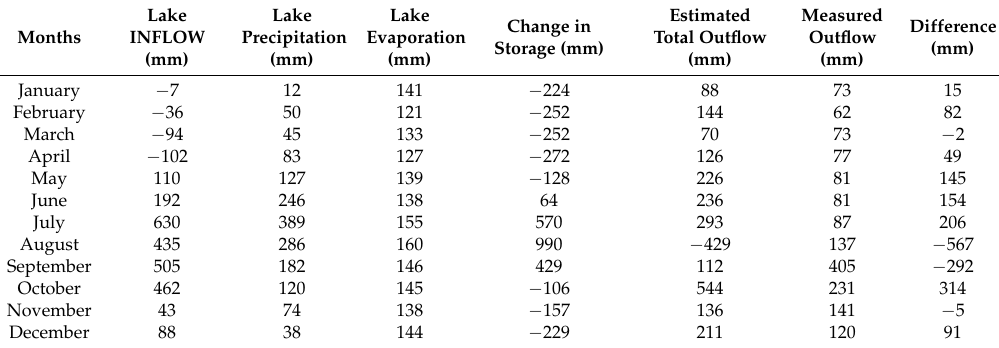
Table 2. Monthly water balance components of Lake Tana.